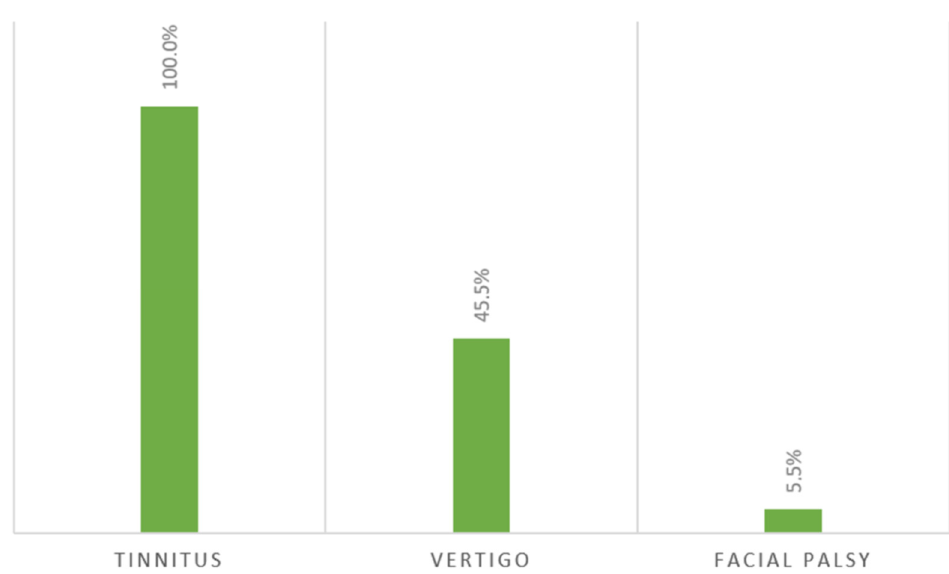
Figure 3. Reported symptoms associated with non-isolated SNHL in COVID-19 patients. In 25% of the SNHL patients, a chemosensory dysfunction (anosmia, hyposmia, ageusia, and dysgeusia) was also described.